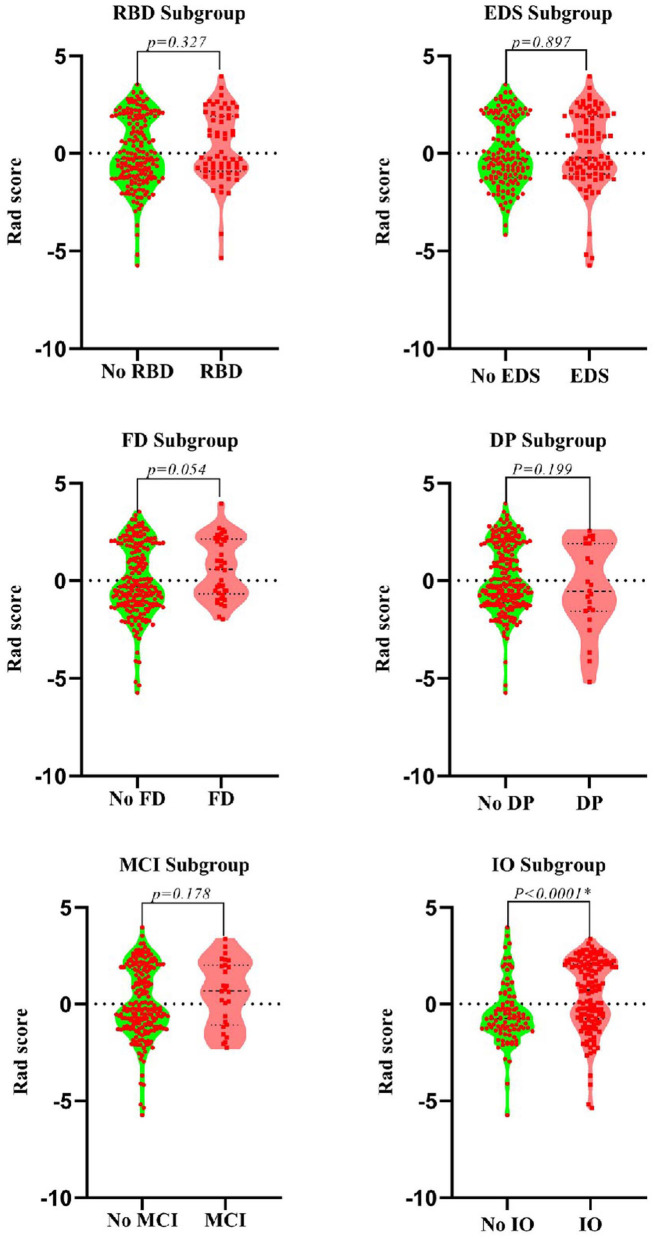
Violin plots of subgroups of patients stratified by non-motor symptoms. The blue line represents the median, and the red lines represent the first and third quartiles. RBD, rapid eye movement sleep behavior disorder; EDS, excessive daytime sleepiness; FD, family history of PD; DP, depression; CD, cognitive decline; IO, impaired olfaction.